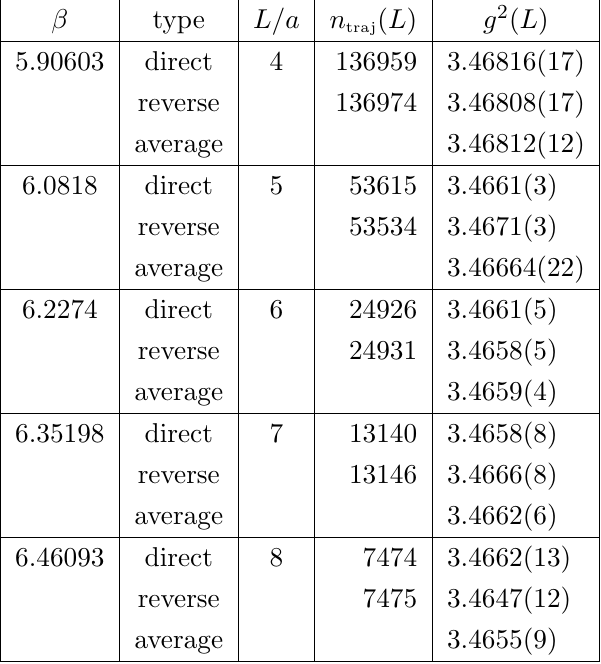
= 1000, and their average, in SU(3) qq